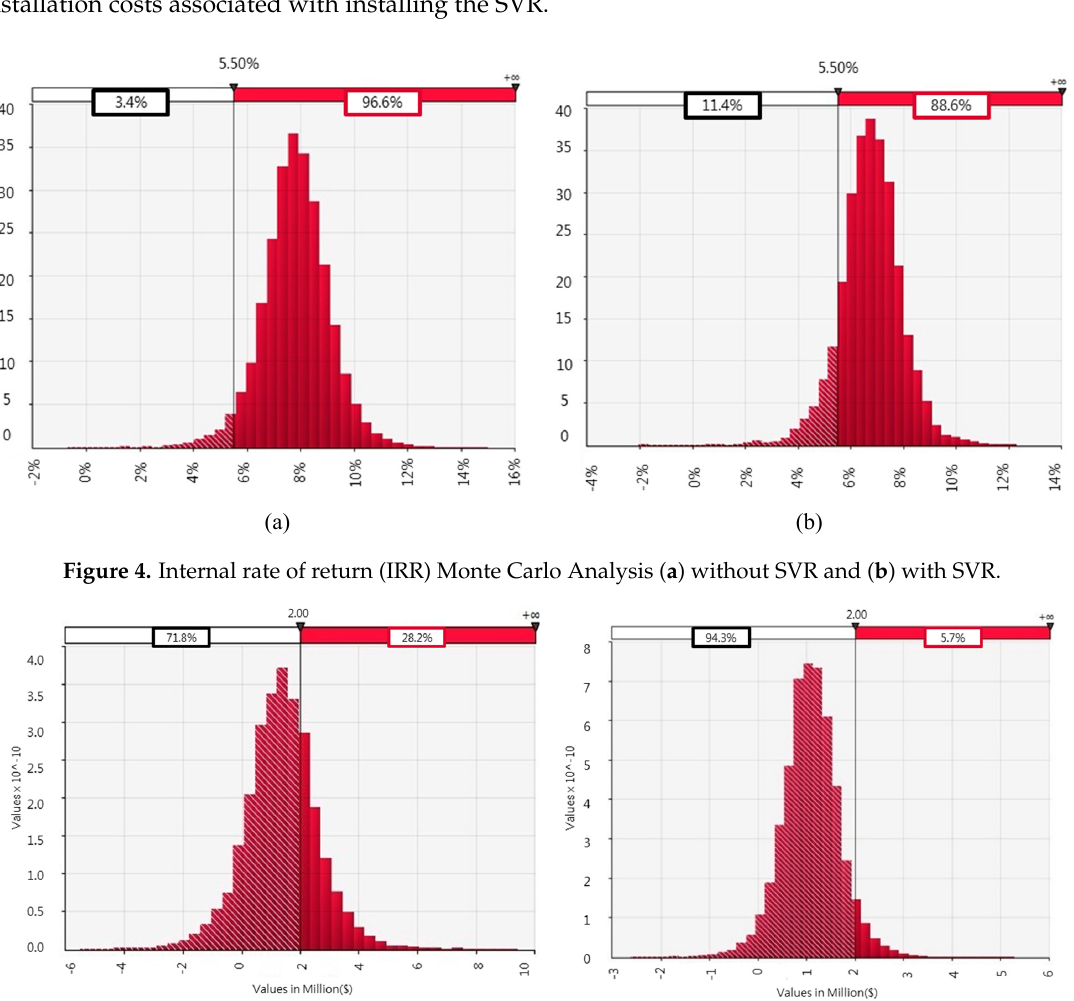
Figure 5. Net present value (NPV) Monte Carlo Analysis ( a ) without SVR and ( b ) with SVR.